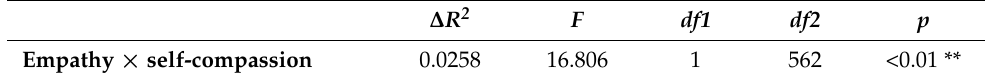
Table 5. Interaction effect of empathy and self-compassion on happiness ( N = 566).